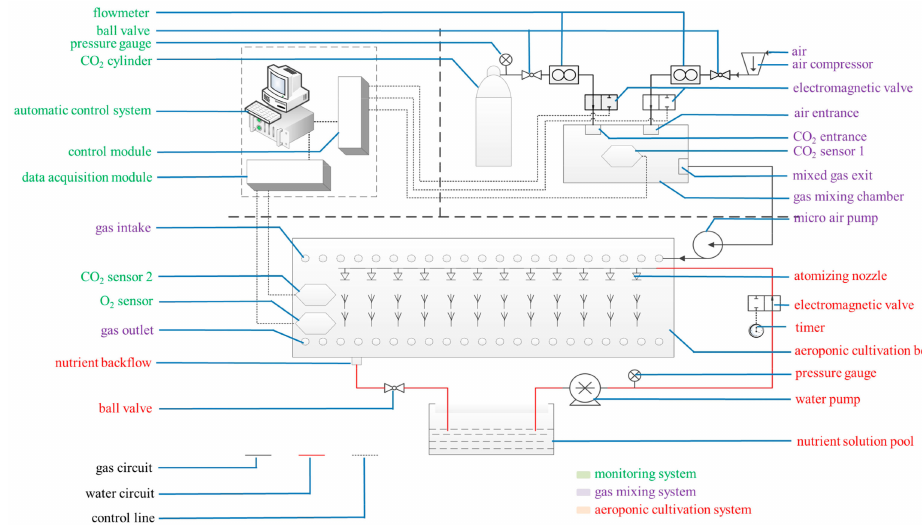
Figure 10. Cultivation and treatment equipment. The system mainly comprised a CO 2 -air mixing system (purple notes), a CO 2 concentration monitoring system (green notes), and an aeroponic cultivation system (red